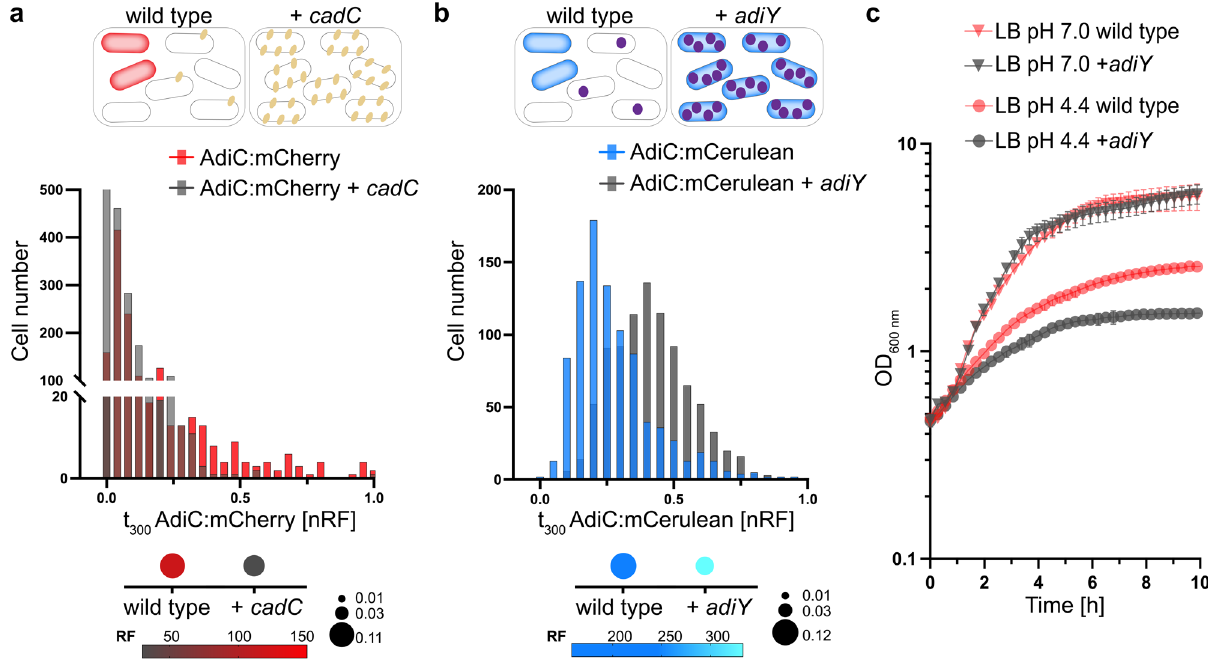
Fig. 5 An increase of the copy number of AdiY or CadC affects the degree of heterogeneity of the Adi system. a nRF values of cells expressing AdiC:mCherry in the wild type background (red) or with an elevated CadC copy number (gray) at pH 4.4 in LB medium at t 300 . + cadC , the expression of cadC under the control of the arabinose (0.1%)-inducible promoter in plasmid pBAD24. The comparison of frequencies of AdiC:mCherry in wild type or + cadC cells using the Chi-square test showed a p -value < 0.001. On top of the histogram: red cells represent the AdiC:mCherry ON state; + cadC is represented by yellow dots. Below the histogram: noise is presented by the size of the dots; average RF is represented by color intensity (Supplementary Table 1). RF was quanti fi ed using the MicrobeJ plugin of the ImageJ software of the fl uorescent microscopic images for 1000 cells per condition. nRF normalized RF values. b nRF values of cells expressing AdiC:mCerulean in the wild type background (blue) or with an elevated AdiY copy number (gray) and cultivated as in (a). + adiY , expression of adiY under the control of the arabinose (0.1%)-inducible promoter in plasmid pBAD24. Comparison of the frequencies of AdiC:mCerulean in wild type or + adiY cells using the Chi-square test showed a p -value < 0.0001. On top of the histogram: blue cells represent the AdiC:mCerulean ON state; + adiY is represented by purple dots. Below the histogram: noise level is represented by the size of the dots; average RF is represented by color intensity (Supplementary Table 1). RF was quanti fi ed using the MicrobeJ plugin of the ImageJ software of the fl uorescent microscopic images for 1000 cells per condition. nRF normalized RF values. c E. coli MG1655 wild type transformed with the plasmid pBAD24- adiY or with empty pBAD24 were grown in minimal medium at pH 5.8 supplemented with lysine and then shifted to LB medium of the indicated pH values. Growth (OD 600 ) was determined every 10 min in microtiter plates with continuous shaking. All experiments were performed three times ( n = 3), and error bars represent standard deviation of the means. LB lysogeny